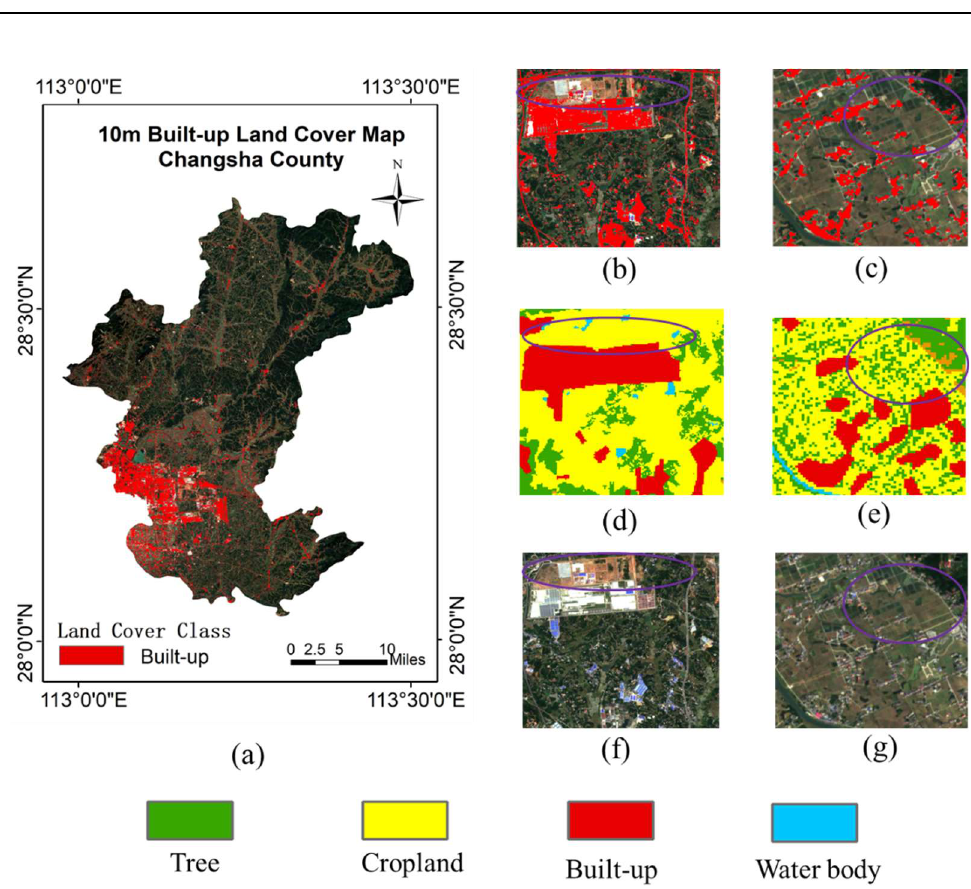
Figure 9. The built-up land cover mapping result in Changsha County. ( a ) The 10 m resolution build-up land cover map of Changsha County confusion matrices results. ( b ) Results of mapping of factory. ( c ) Results of mapping of small settlements. ( d ) The 30 m land cover map for factory. ( e ) The 30 m land cover map for small settlements. ( f ) Remote sensing imagery of factory. ( g ) Remote sensing imagery of small settlements. Table 4. Results in Changsha County.